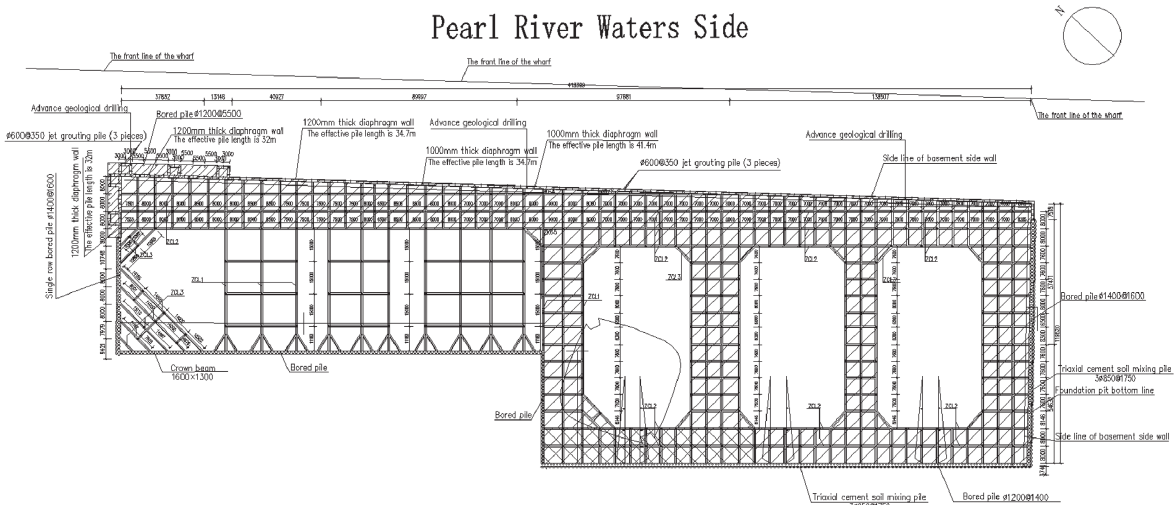
Figure 26: Plane layout of the foundation pit support.